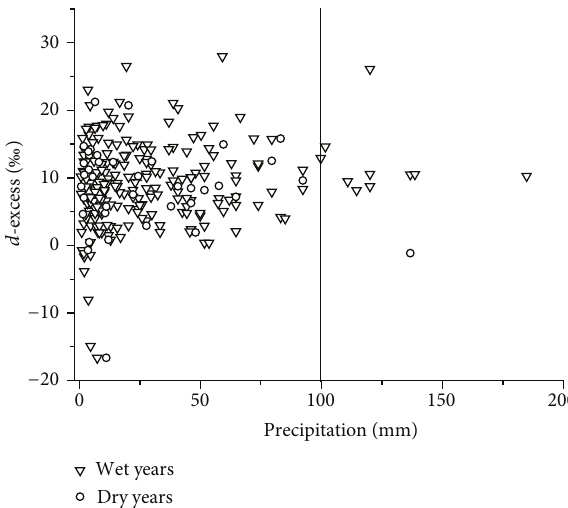
Figure 13: Dependence of d -excess on the rainfall